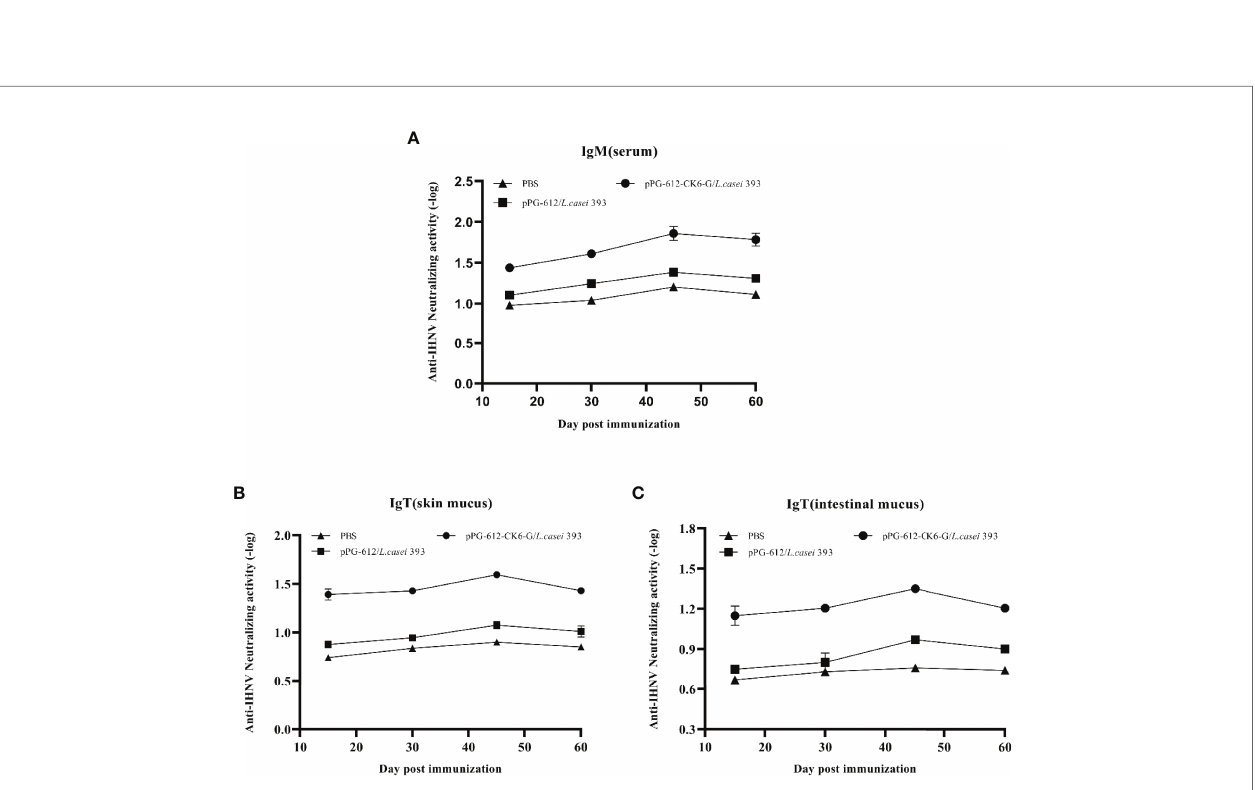
FIGURE 5 | Levels of antibody-neutralizing virus in different immunized tissues at 60 days after secondary immunization. (A) Changes in antibody neutralization levels in serum at different time periods; (B) changes in antibody neutralization levels in skin mucosa at different time periods; (C) changes in antibody neutralization levels in intestinal mucosa at different time periods. Data are presented as mean ±